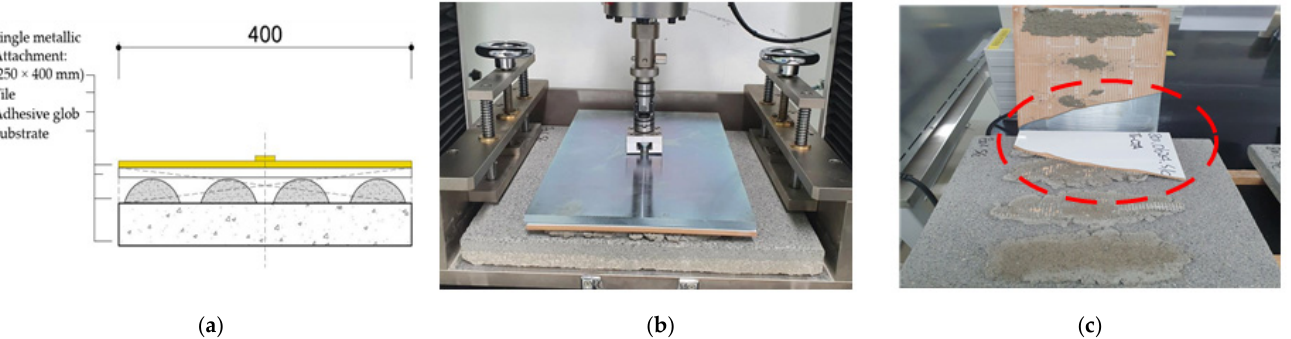
Figure 9. Entire tile-pull-off testing attempt: ( a ) testing plan (unit: mm); ( b) testing site; ( c ) testing results (fracture at the edge sections of the tiles).